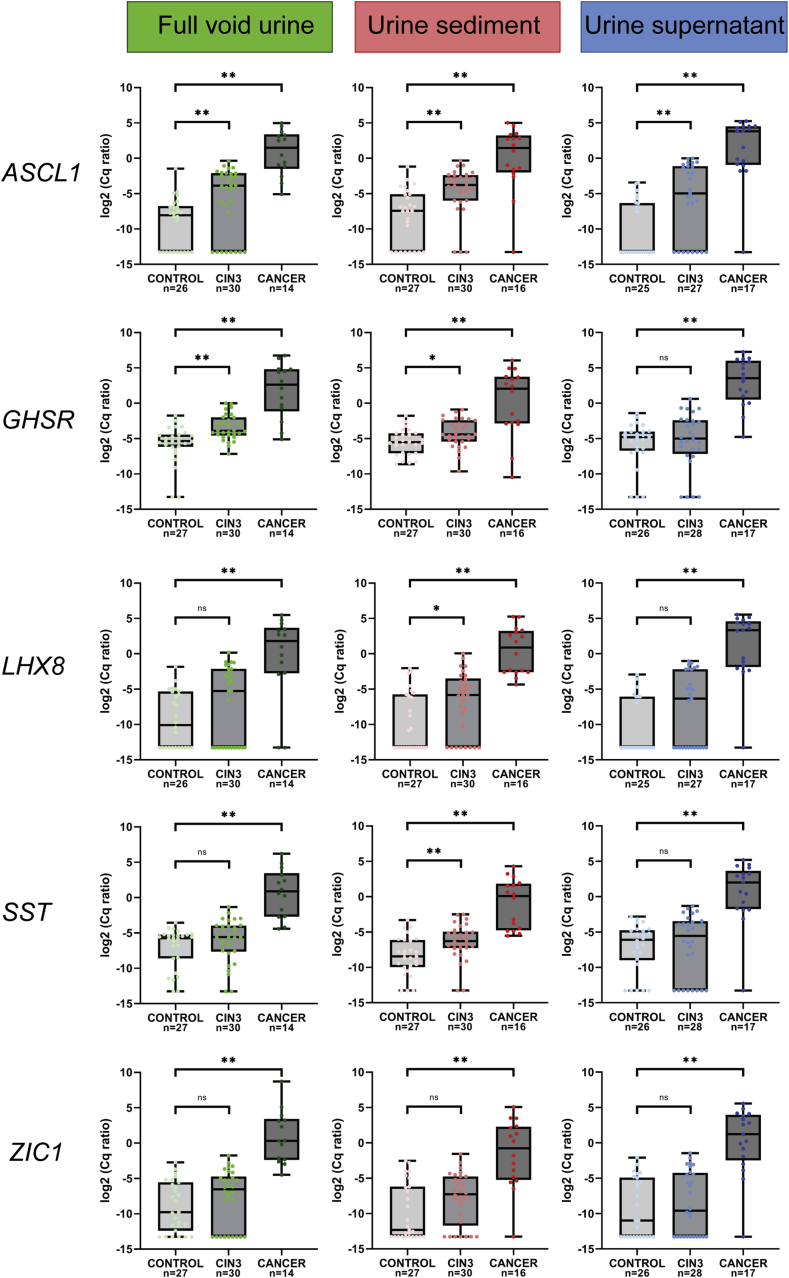
Methylation levels of ASCL1, GHSR, LHX8, SST and ZIC1 in full void urine (green), urine sediment (red) and urine supernatant (blue) from 27 healthy female controls, 30 women with CIN3 and 17 women with cervical cancer. Methylation levels are shown by the log2-transformed Cq ratios. Boxplots show medians with lower and upper quartile and range whiskers. **p < 0.005 * p < 0.025 ns p > 0.025. (For interpretation of the references to colour in this figure legend, the reader is referred to the Web version of this article.)